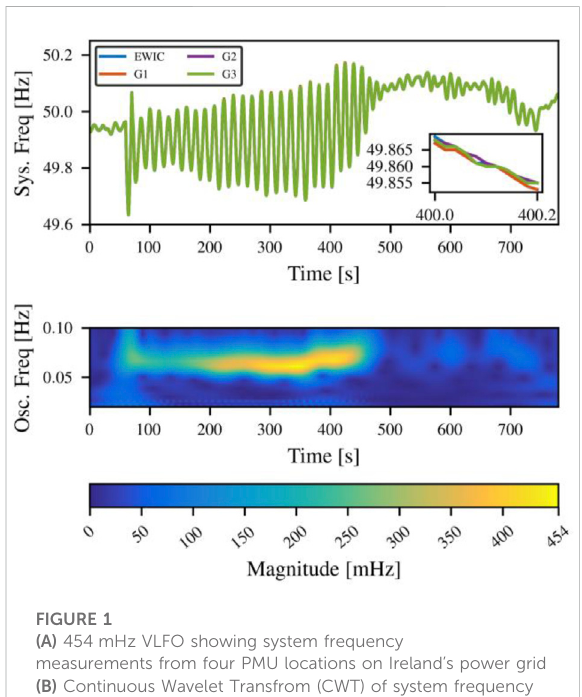
FIGURE 1 (A) 454 mHz VLFO showing system frequency measurements from four PMU locations on Ireland ’ s power grid (B) Continuous Wavelet Transfrom (CWT) of system frequency shown in (A)